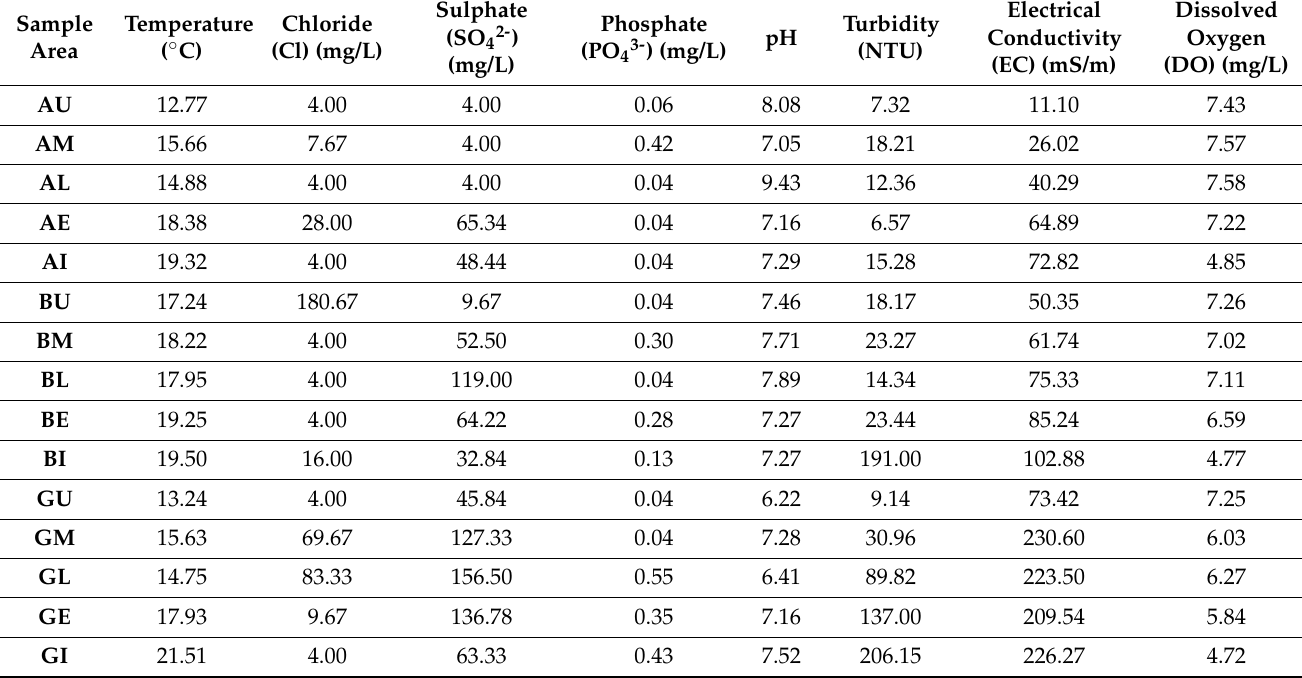
Table 2. Statistical variables of annual water quality parameters of the river basins of Tyhume, Buffalo, and Bloukrans Rivers and their municipal wastewater treatment plants.